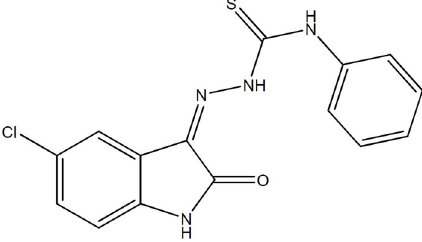
Figure 2. Structure of the isatin derivative (Z)-2-(5-chloro- 2-oxoindolin-3-ylidene)-N-phenyl-hydrazinecarbothioamide